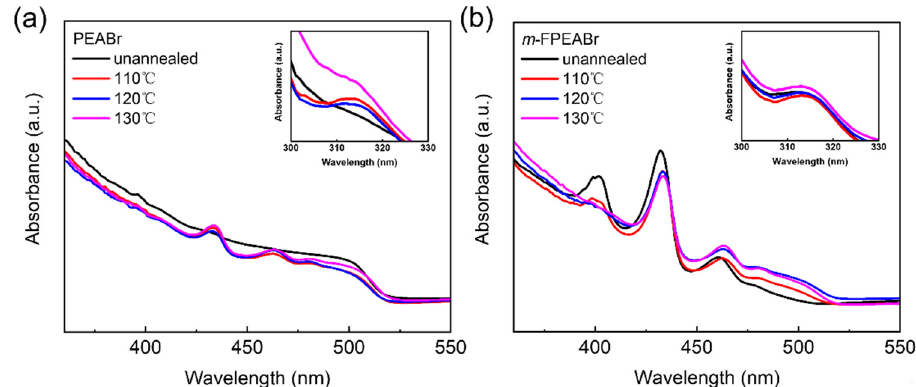
Figure 5. Absorption spectra of ( a ) PEABr and ( b ) m -FPEABr perovskite films at different annealing temperatures.